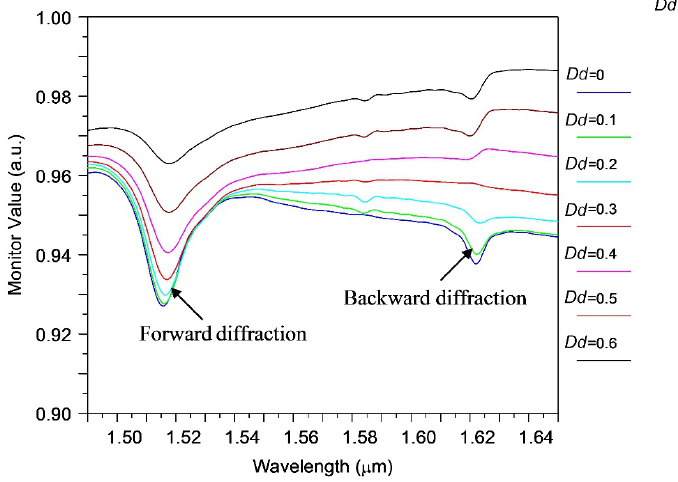
Figure 4. Transmission spectrum of silicon waveguide in the presence of periodic segmental structure surrounded by water for different inclination angles determined by Dd